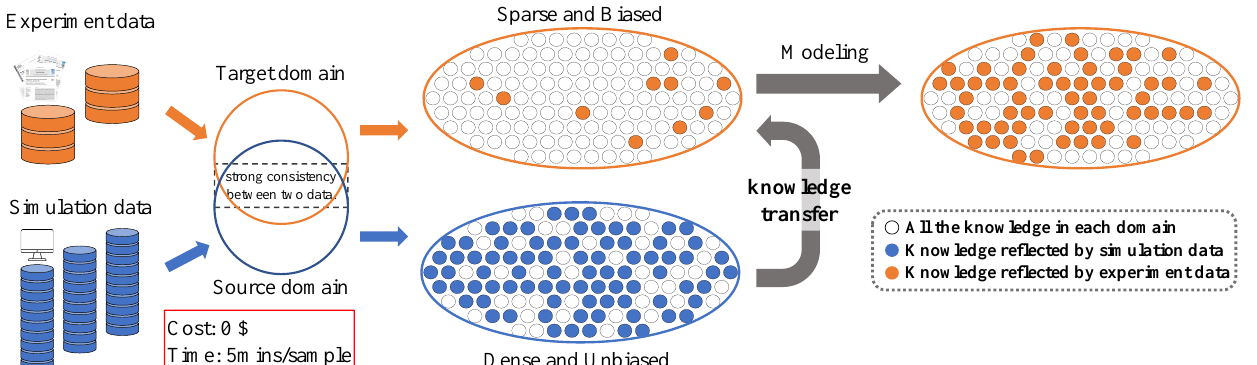
Figure 1. Strategy for alloy material properties prediction in this work. ( a ) Measuring the properties of alloy materials through traditional material experiments will face the challenge of high cost and high time consumption. ( b ) The data used by conventional machine learning methods for material properties prediction often suffer from the obstacles of small data size and biased label distribution. ( c ) In this work, we propose a machine learning modeling strategy that uses knowledge transfer to solve the challenges of predicting alloy properties and the obstacles of conventional machine learning